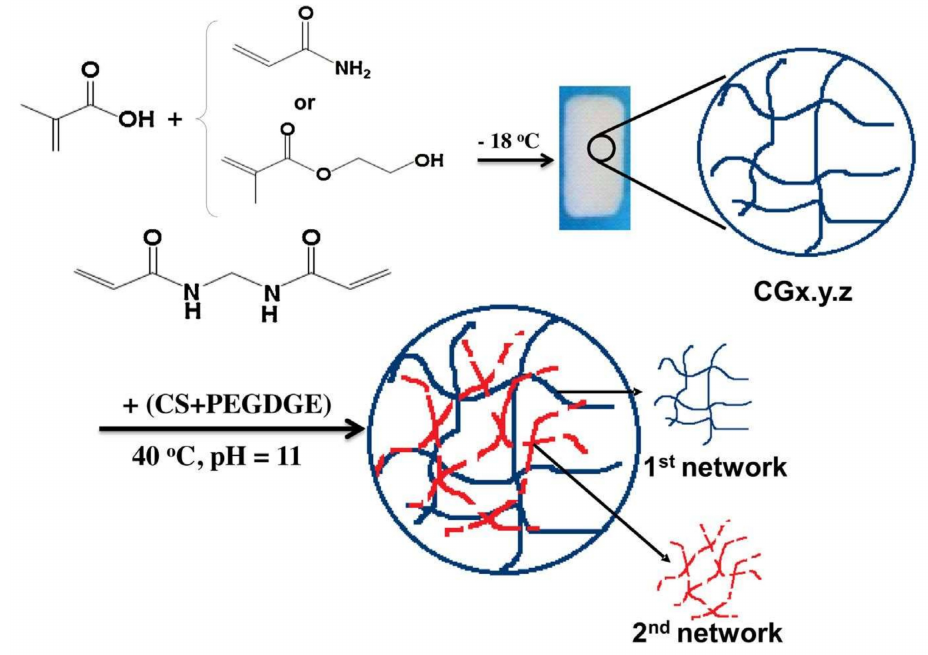
Figure 6. Synthesis strategy of supermacroporous composite cryogel. (CGx.y.z: first network, x: monomer ratio, y: cross-linking ratio, and z: initial monomer concentrations). Republished with permission from [52]. Copyright 2016